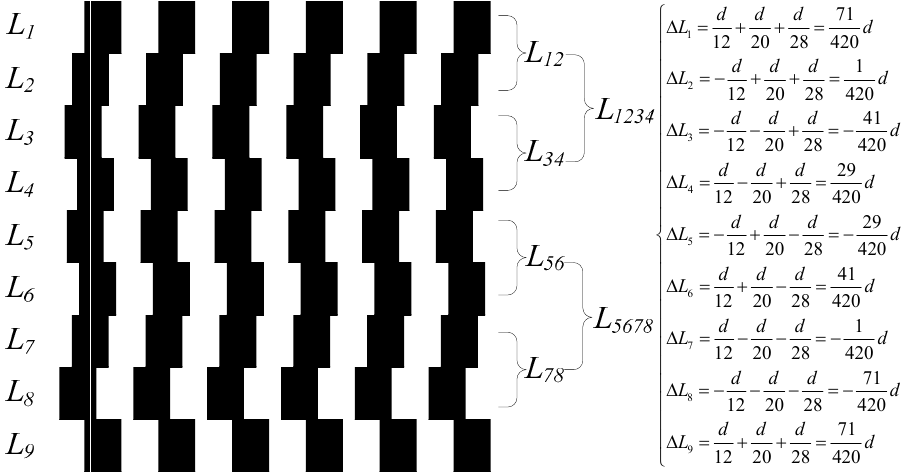
Figure 7. Phase-shift pattern of index grating and moving distance of each Figure 7. Phase ‐ shift pattern of index grating and moving distance of each row. In general, dividing the index grating’s grid lines into eight rows is sufficient to sup ‐ press harmonics. The ninth row is added in consideration of installation and adjustment.